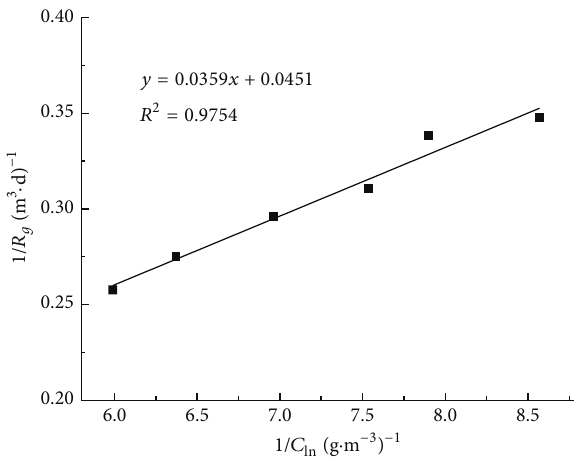
Figure 8: Fitting result of biotrickling filter system for ethanethiol